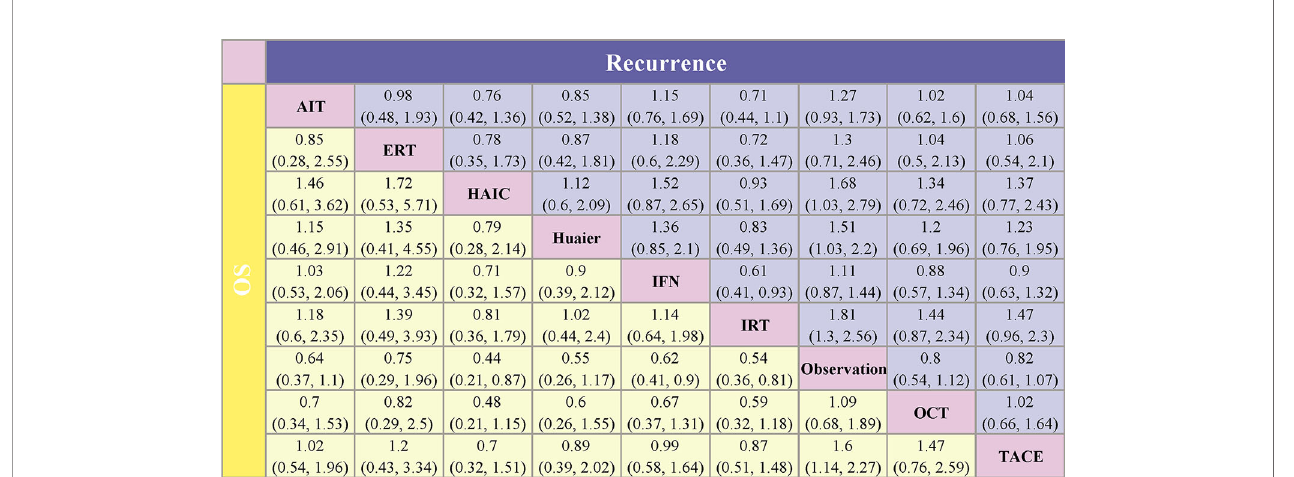
FIGURE 4 | Pooled estimates of the network meta-analysis. Data in each cell are hazard or odds ratios (95% con fi dence intervals) for the comparison between the column de fi ning intervention and the row de fi ning intervention. For the lower triangle (overall survival), hazard ratios less than 1 favor the treatment in the corresponding column. For the upper triangle (recurrence), odds ratios less than 1 favor the treatment in the corresponding row. AIT, adoptive immunotherapy; ERT, external radiotherapy; HAIC, hepatic artery infusion chemotherapy; IFN, interferon; IRT, internal radiotherapy; OCT, oral chemotherapy; TACE, transarterial chemoembolization.